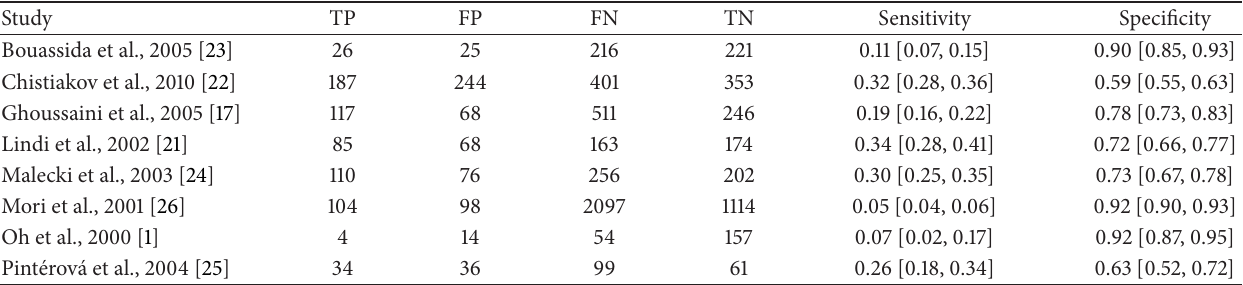
Table 4: Sensitivity and specificity for Pro 12 Ala polymorphism and T2D.